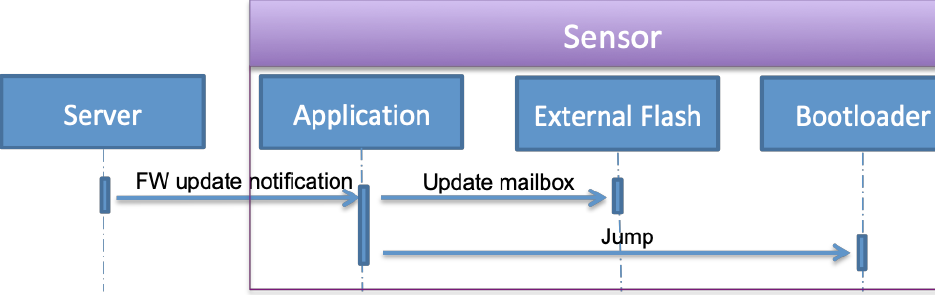
Figure 7. Firmware update notification operations.